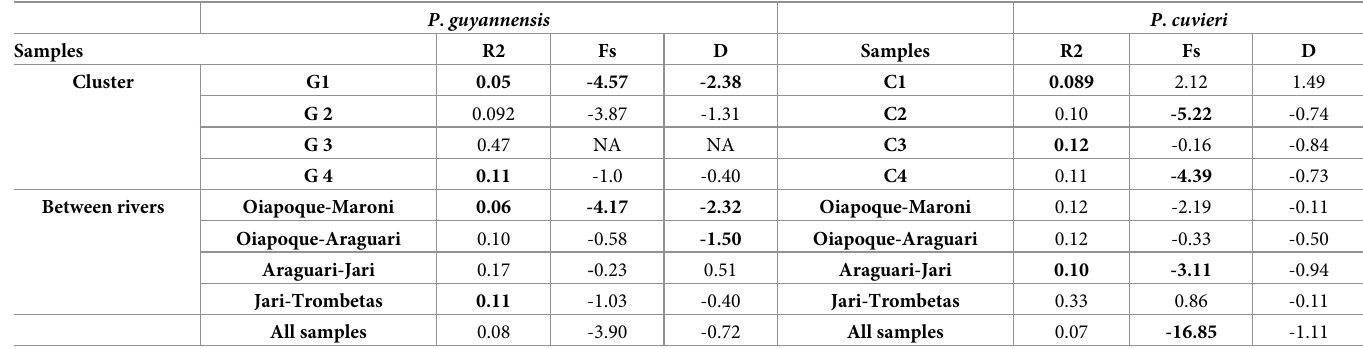
Table 4. The values of R2 [68], Fs [66], and D [67] for the clusters recuperated by the BAPS ( P . guyannensis : G1, G2, G3, and G4; and P . cuvieri : C1, C2, C3, and C4), and for the principal interfluves in the study area (samples between Oiapoque and Maroni rivers, between Oiapoque and Araguari rivers; Araguari and Jari riv- ers and Jari and Trombetas rivers), and the complete